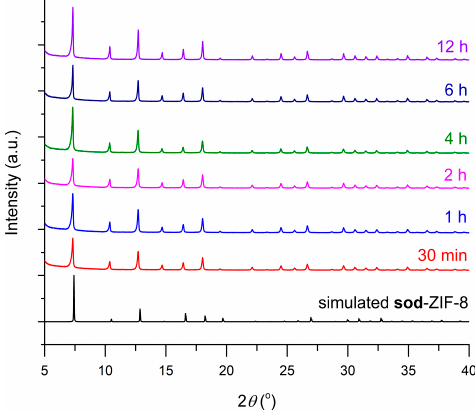
Figure A1. Native electrophoresis of commercial HRP and activity bands in gels after incubation in 5% pyrogallol: 1—commercial HRP, 2 –ox ‐ HRP (2.5 mM NaIO 4 ), 3 –ox ‐ HRP (5.0 mM NaIO 4 ), 4 –ox ‐ HRP (50.0 mM NaIO 4 ).